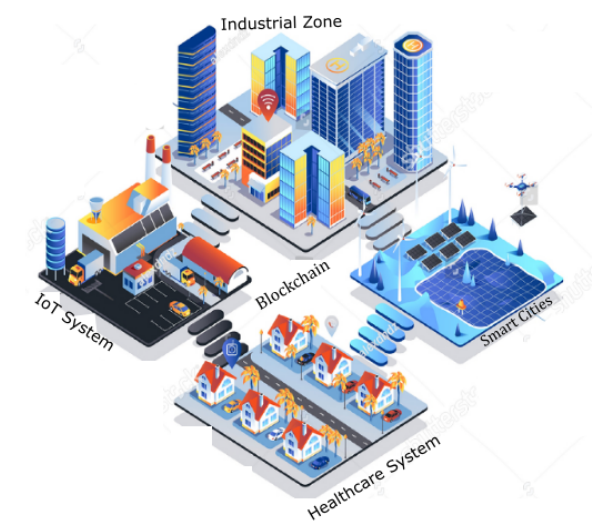
Figure 1. Applications of blockchain